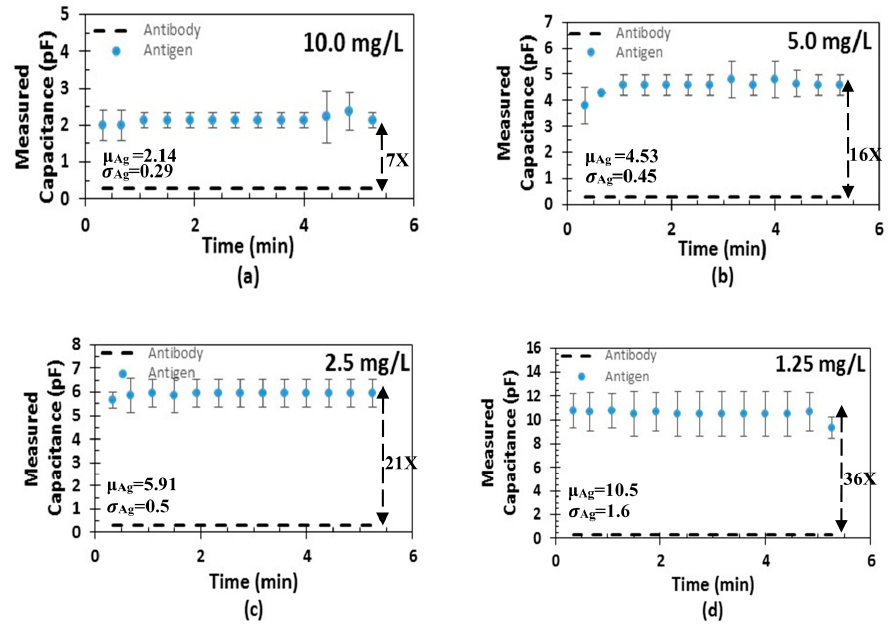
Figure 11. Sensor response to different concentrations of antigens: ( a ) 10 mg/L; ( b ) 5 mg/L; ( c ) 2.5 mg/L; ( d ) 1.25 mg/L.